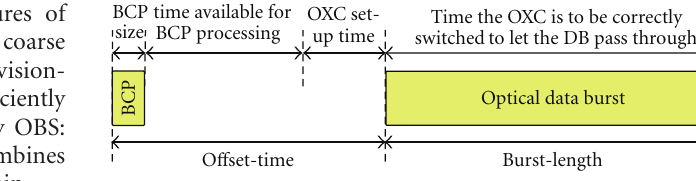
Figure 1: Data-Burst and the preceding Burst-Control-Packet.